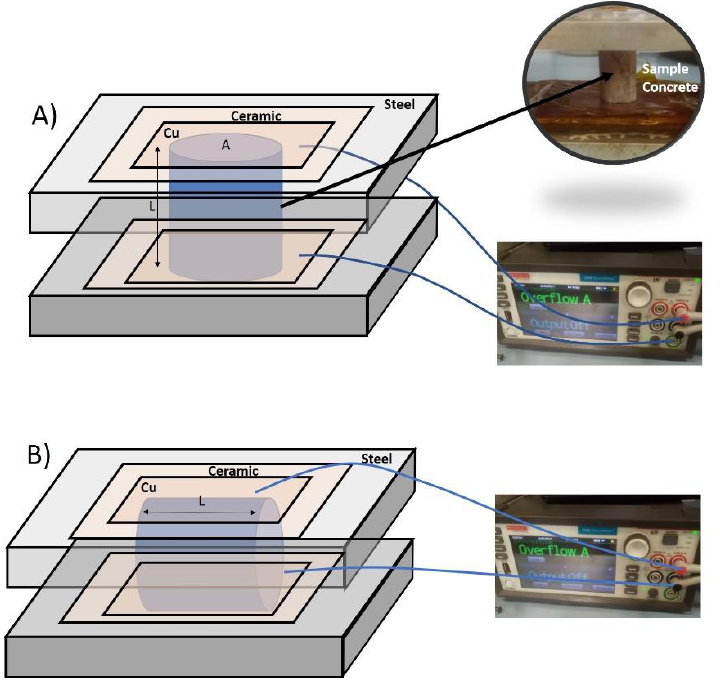
Figure 1. Experimental set-up to measure the electrical conductivity in ( A ) transverse direction, ( B ) longitudinal direction. ( B ) longitudinal